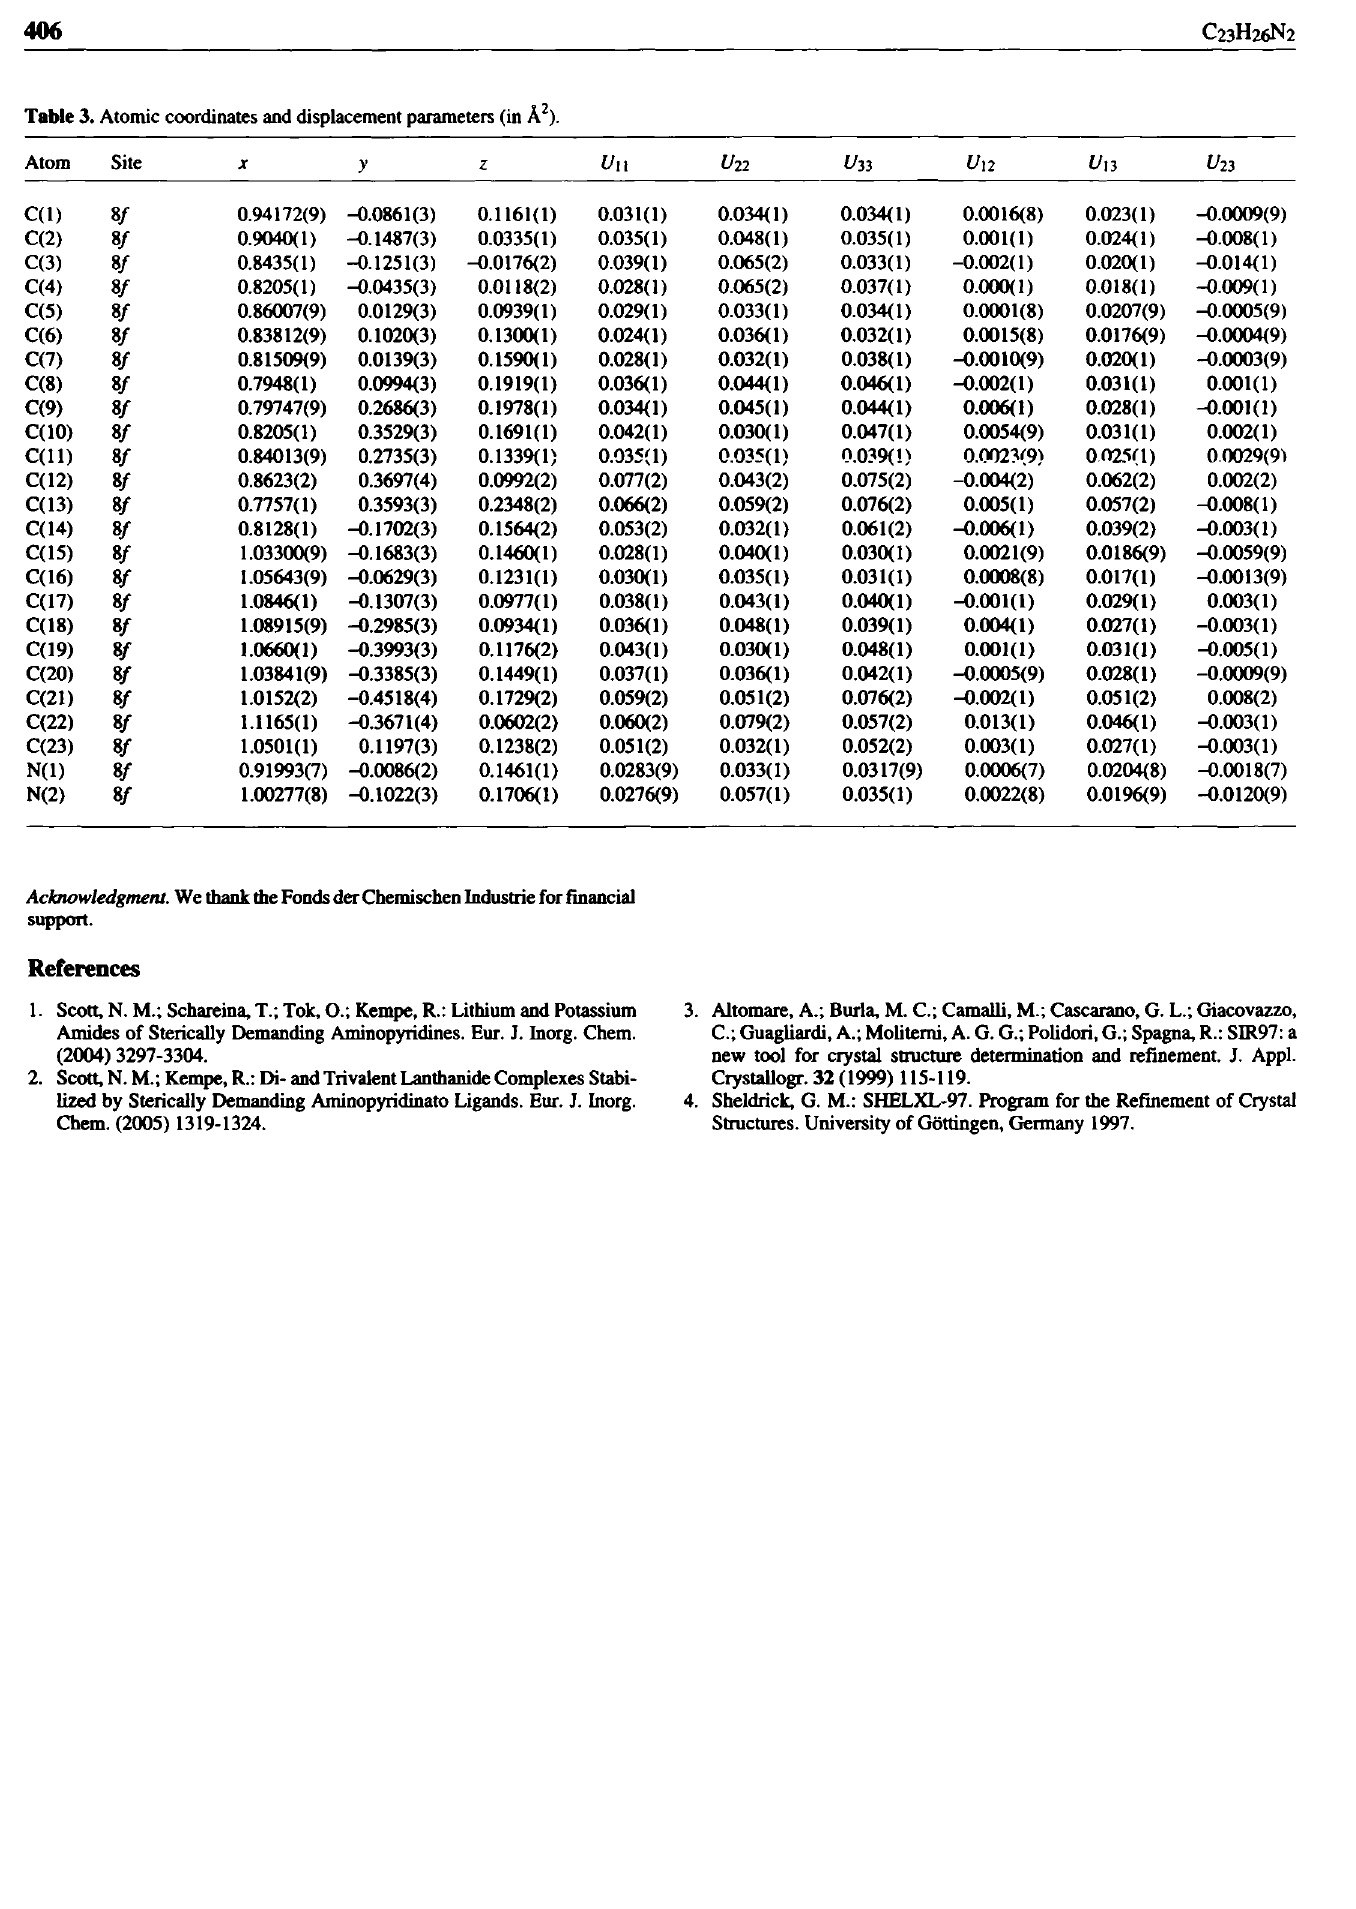
Table 3. Atomic coordinates and displacement parameters (in A 2